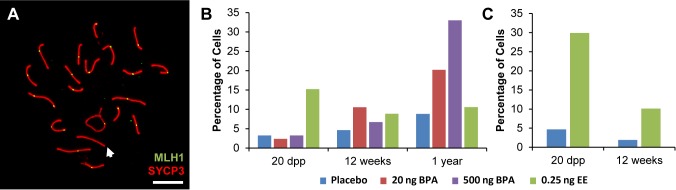
Analysis of pachytene cells from CD-1 and C3H males.A) Representative spermatocyte with an SC lacking an MLH1 focus (white arrow) from an adult C3H male orally exposed to 0.25 ng EE from 1–12 dpp. MLH1 = green, SYCP3 = red. B, C) The frequency of cells with an SC lacking MLH1 in placebo and exposed males analyzed at 20 dpp, 12 week-old, and 1 year-old CD-1 males (B) and 20 dpp and 12 week-old C3H males (C). Differences were tested by Chi-square analysis. For CD-1, X2 = 51.70 (p<0.0001) at 20 dpp, X2 = 3.57 (p>0.05) at 12 weeks, and X2 = 1.56 (p>0.05) at 1 year-old. For C3H, X2 = 32.87 (p<0.0001) at 20 dpp, and X2 = 13.95 (p<0.001) at 12 weeks.